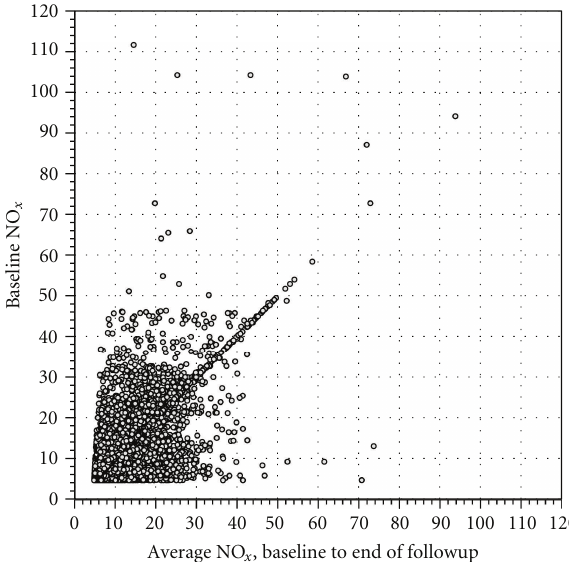
Figure 2: Scatterplot of the NO x concentrations at inclusion versus follow-up average concentrations (Pearson correlation coe ffi cient = 0.80).